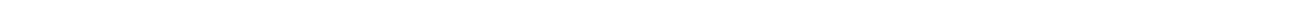
Fig. 3 H3.3 acts as barrier during the early stage of reprogramming. a Line plot demonstrating the dynamic H3.3 enrichment on the fi broblast genes-set during cellular reprogramming. Y -axis represents the normalized number of reads mapping to the genebodies of these genes at the indicated time-points ( x -axis). b Line plot demonstrating the dynamic H3.3 enrichment on the mesenchymal genes-set during cellular reprogramming. Y -axis represents the normalized number of reads mapping to the genebodies of these genes at the indicated time-points ( x -axis). c Heatmap revealing the dynamic expression of the top 250 genes, which are depleted of H3.3 enrichment at any time-point during cellular reprogramming. The values are per-row normalized FPKM values and colour ranges from dark blue (low expression) to dark red (high expression). d Protein – protein interaction network formed by the top 250 genes, which lose H3.3 enrichment at any time-point during cellular reprogramming. Each node represents a protein and the cellular localization of the protein is indicated by the colour of the node according to the key. Black lines (edges) represent protein – protein interaction. e Heatmap revealing the enrichment of transcription factor motifs in the intergenic regions bound by H3.3 in the reprogramming cells (both successful and unsuccessful). Enrichment ranges from not enriched (white) to highly enriched (dark red). f Schematics of the si H3.3 knockdown experiment (top). The bar chart below represents the number of AP-stained colonies ( y -axis) observed in wells in which the knockdown of H3.3 had been performed. Non-targeting siNT constructs were used as controls. Values are mean ± s.e.m from independent replicate experiments ( n = 3). Two-tailed t -test was used for statistical analysis. Error bars represent standard